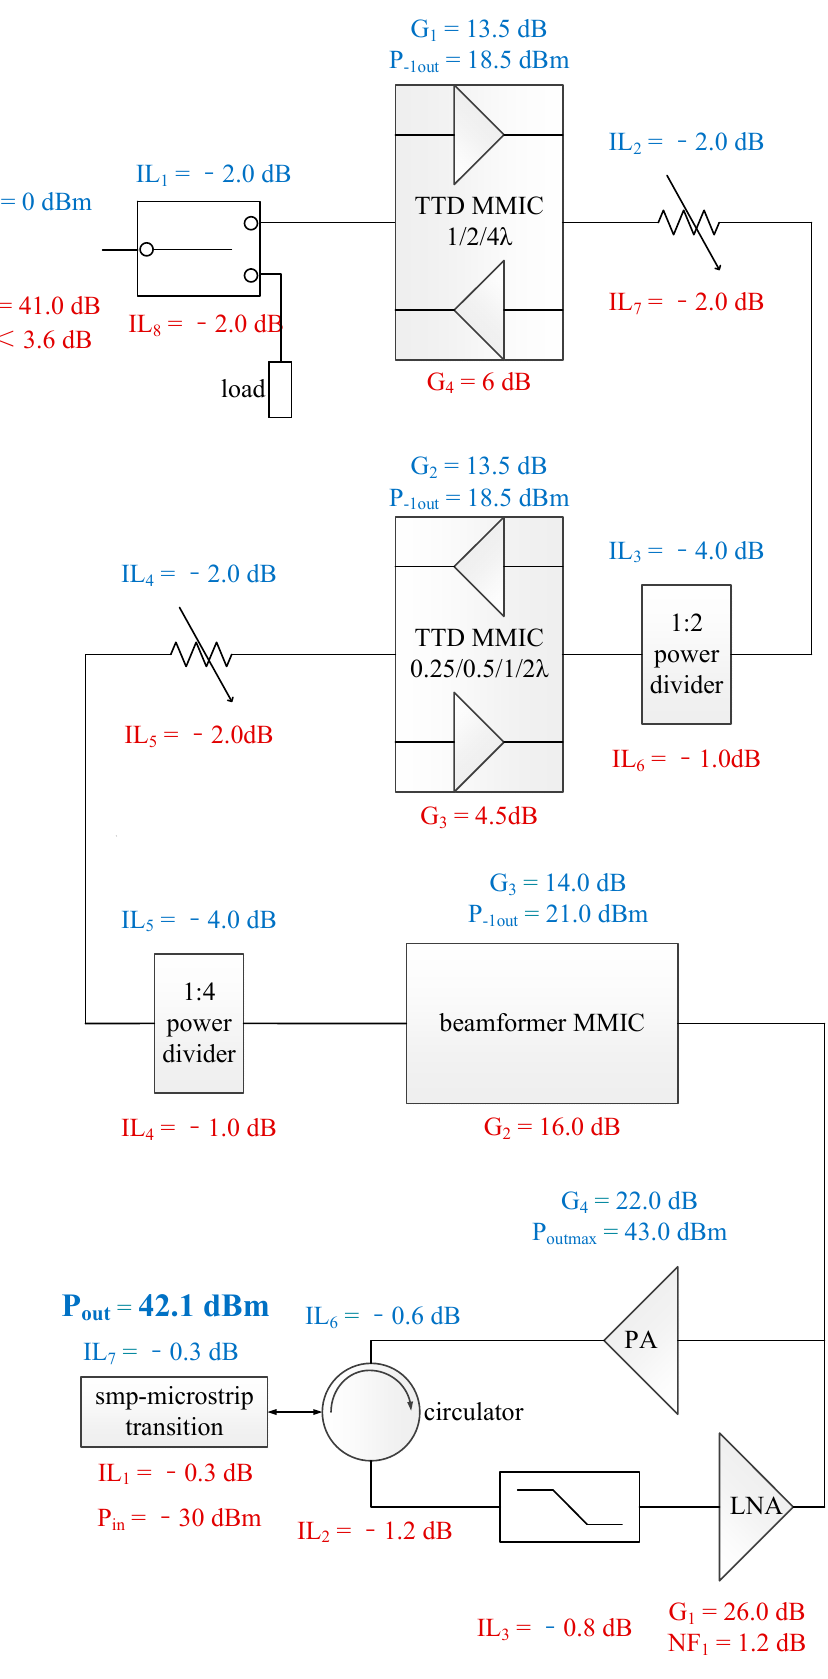
Figure 2. Link budget of receive (red) and transmit (blue).